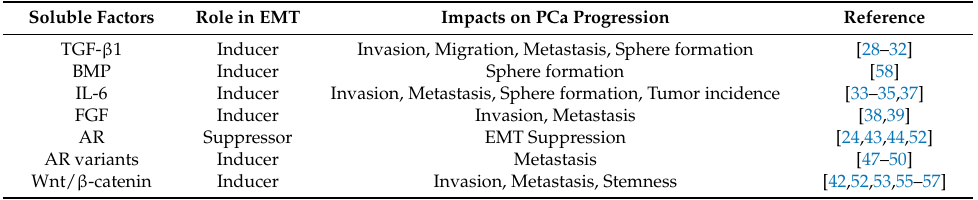
Table 1. Microenvironment soluble factors involved in EMT progression of